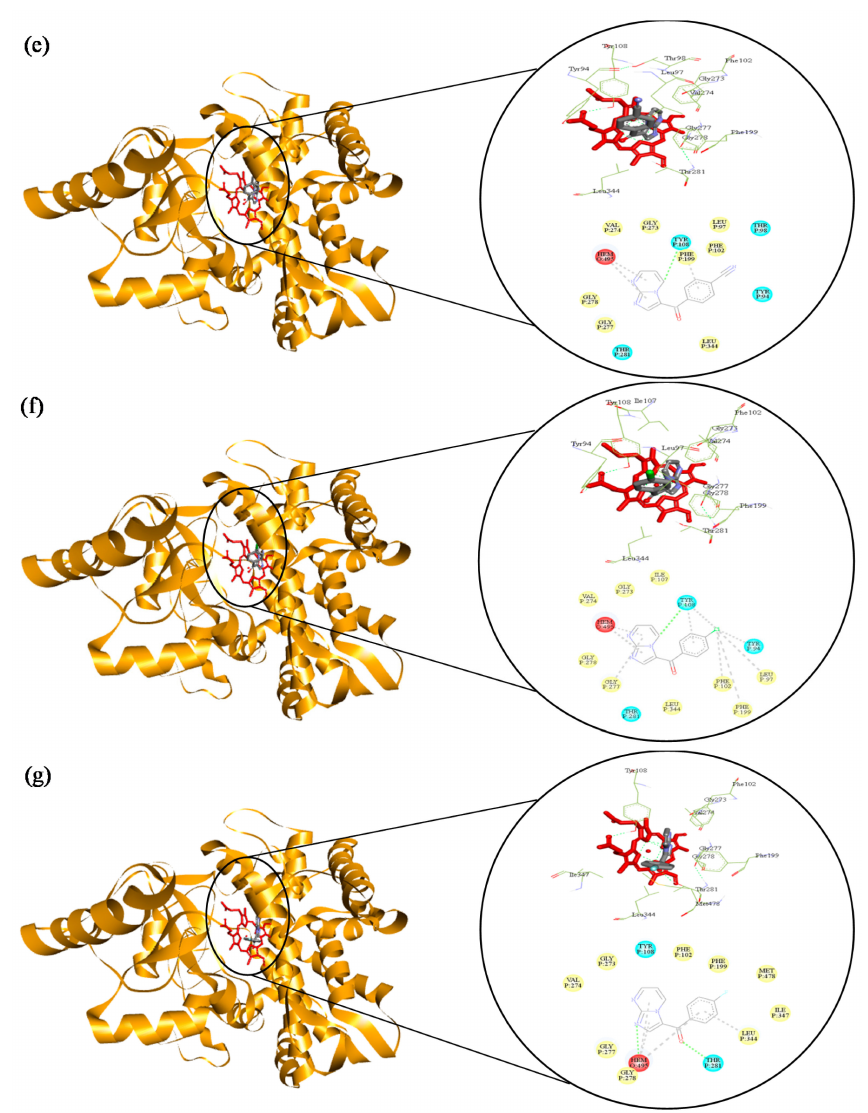
Figure 3. Schematic representation of the interactions of the five 3-benzoyl imidazo[1,2- a ]pyrimidines and the two reference compounds with CYP51 Ck . The flat ribbon denotes CYP51 Ck , and the stick model portrays the heme group in red and the compounds in gray (( a ), fluconazole; ( b ), ketoconazole; ( c ), 4a ; ( d ), 4d ; ( e ), 4f ; ( f ), 4i ; and ( g ), 4j ) within the active site of the enzyme. The coupling of the compounds with amino acid residues from the active site of CYP51 Ck are illustrated in a 3D model. The 2D model shows hydrophilic interactions (green dotted lines), hydrophobic interactions (gray dotted lines) and electrostatic interactions (without lines). Polar amino acids (cyan blue) and non-polar ones (green) are displayed in the